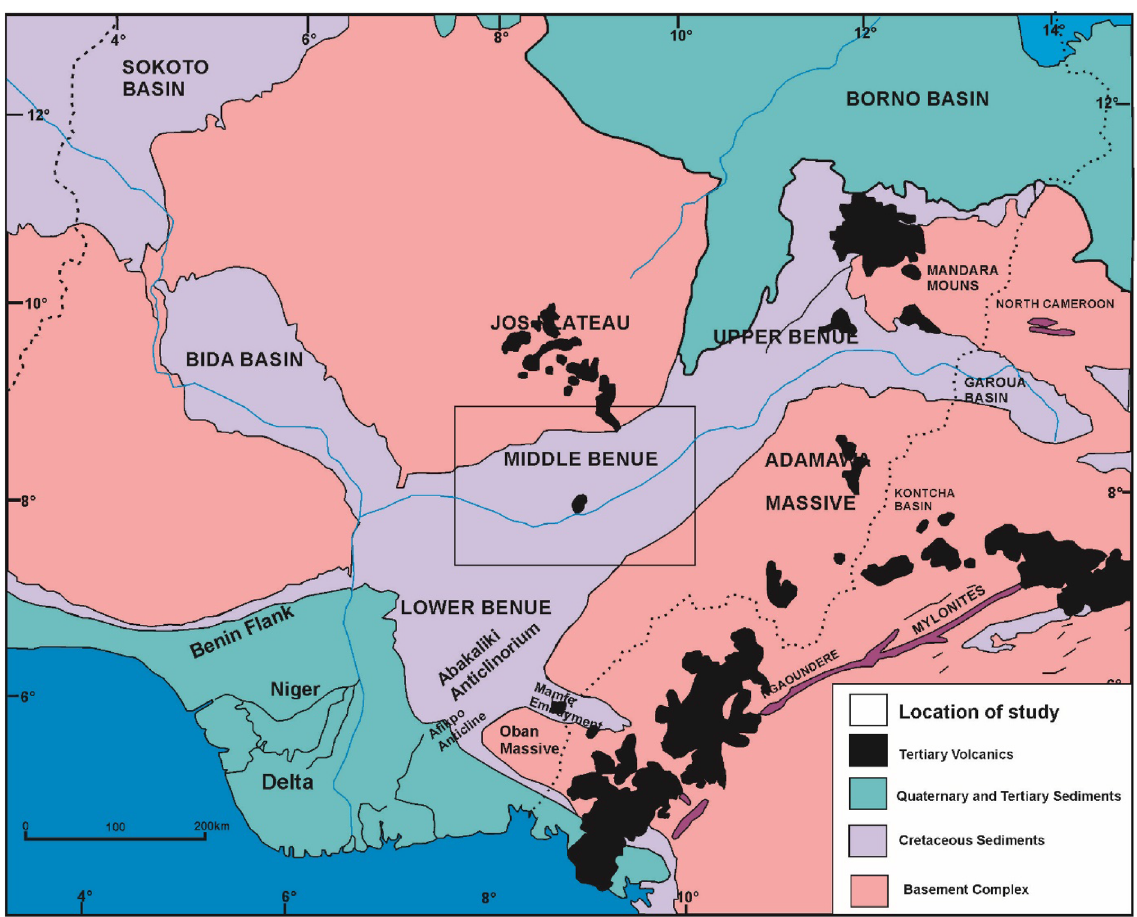
Figure 1. Regional geology and location of the study area (modified after Benkhelil 31